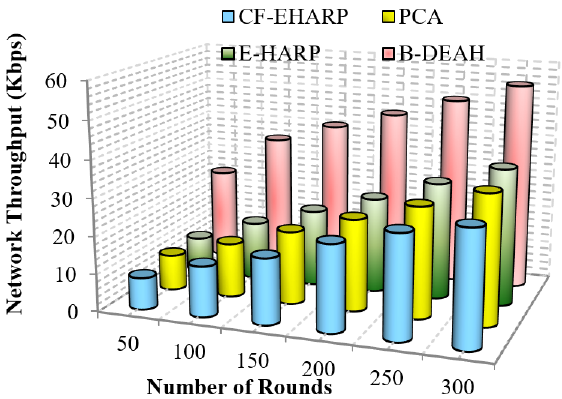
Figure 9. Network throughput vs. simulation rounds (periodic